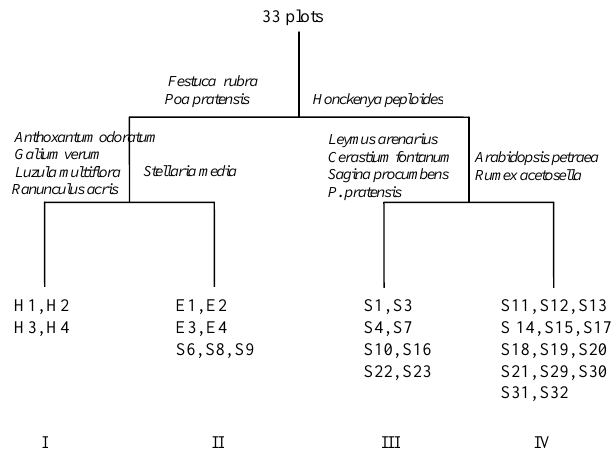
Figure 7. TWINSPAN-classification of permanent plots sampled on Surtsey (S), Heimaey (H) and Elliðaey (E) in 2012–2013. Species most decisive (indicators) of each division are shown and the four groups formed.